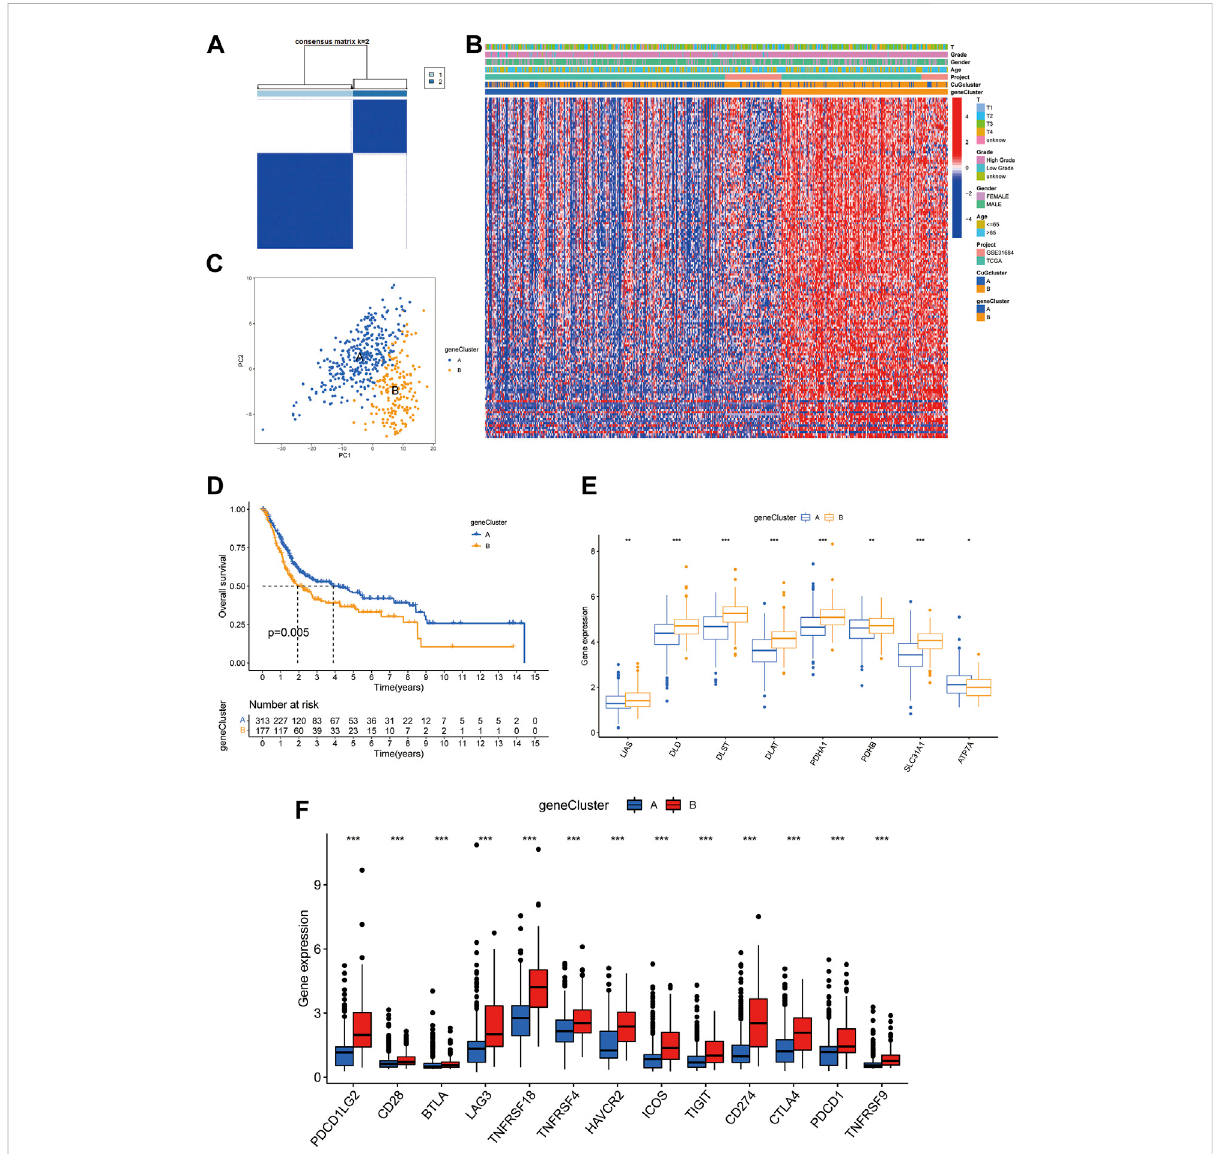
FIGURE 4 Prognostic and TME characteristics between two cuproptosis gene clusters in BLCA. (A) The consensus score matrix of all the samples by unsupervised clustering analysis based on the differential genes between the two cuproptosis patterns. (B) Heatmap depicted the clinical features and expression of differential genes between the two gene clusters. (C) PCA of the two gene clusters: cluster A (blue) and cluster B (orange). (D) Kaplan-Meier curves for the two gene clusters. (E,F) Boxplots showed different CuGs (E) and immune checkpoints (F) expression between the two gene clusters. * p < 0.05, ** p < 0.01, *** p < 0.001. Abbreviations: TME, tumor microenvironment; BLCA, bladder cancer; PCA, principal component analysis; CuGs, cuproptosis